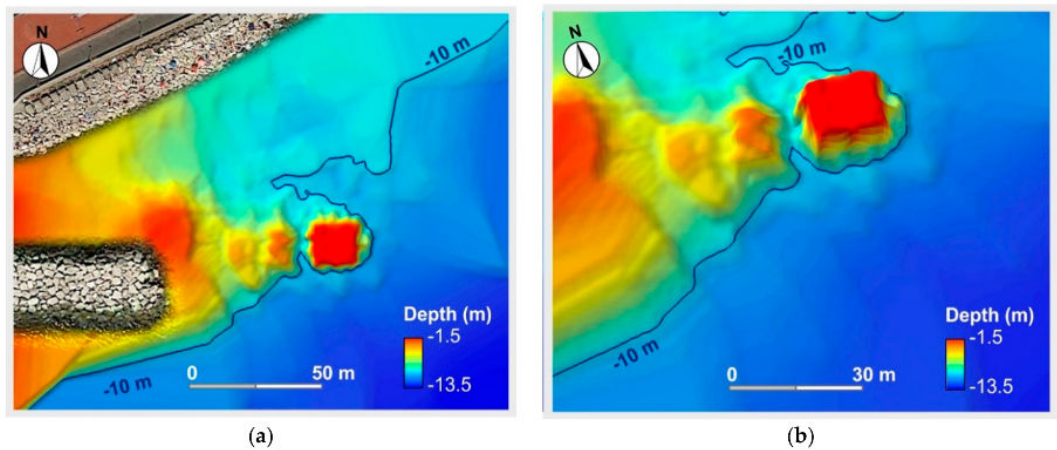
Figure 12. ( a ) 2D view of DTM of Nisida coastal archaeological site; and ( b ) 3D view of DTM of Nisida coastal archaeological site.